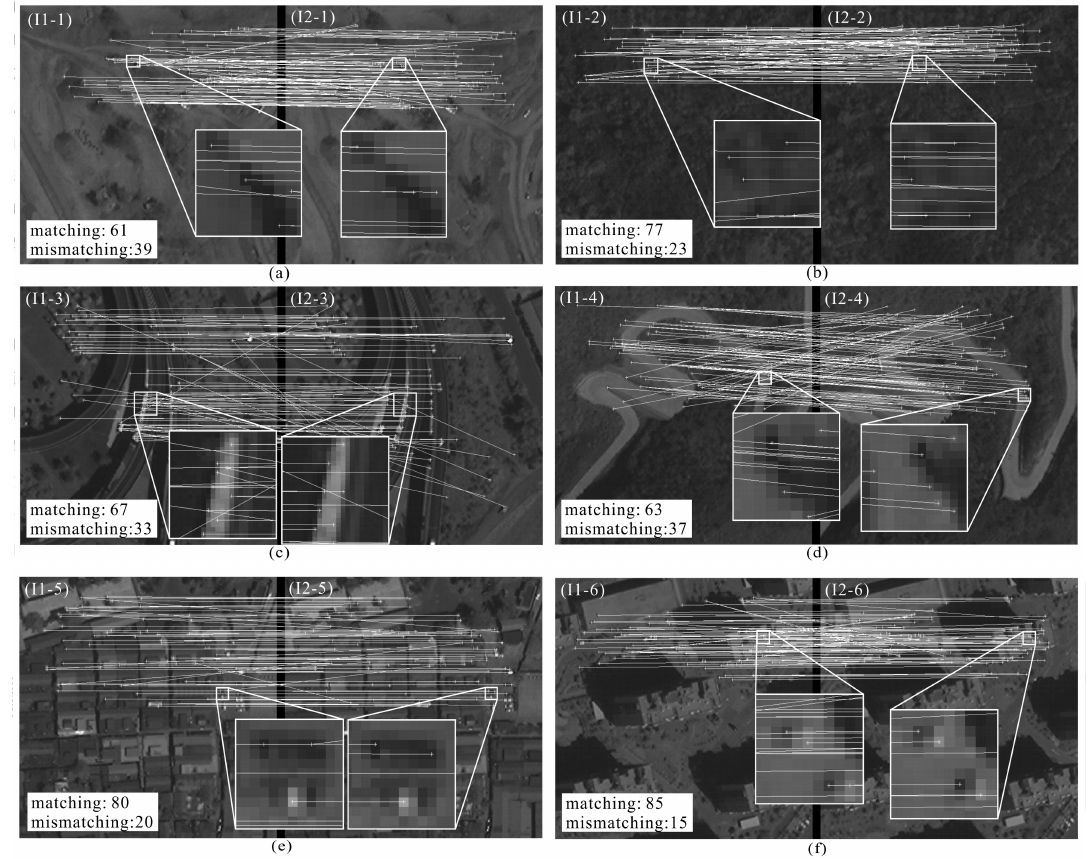
Figure 11. Matching results of six image pairs, ( a ) bare soil; ( b ) trees; ( c ) expressways; ( d ) rural roads; ( e ) bungalows; ( f ) high-rise